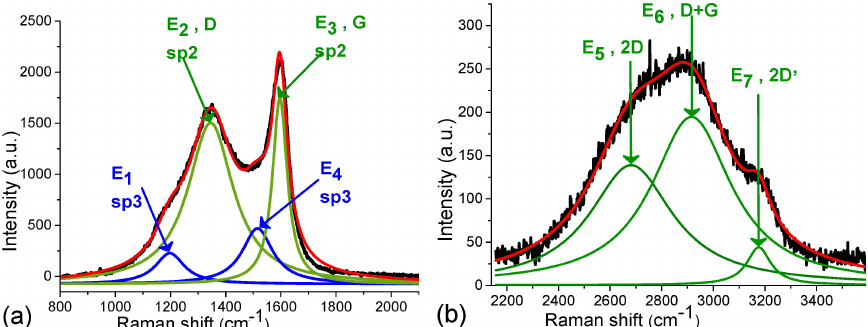
Figure 4. Sample N1 Raman spectra at 532 nm in the range 800–2100 cm − 1 ( a ) and second ordered RS in the range 1900–3700 cm − 1 ( b ). Decomposition into the Lorentz components with energies in their maxima E1–E7, given in Table 3, is